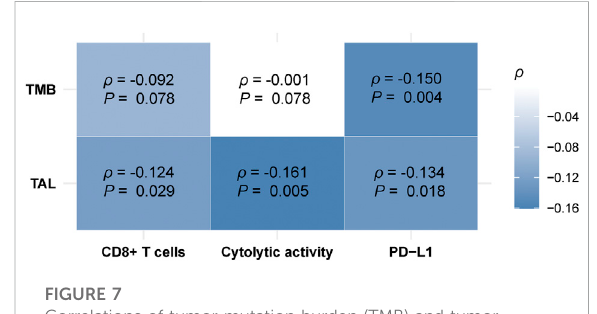
FIGURE 7 Correlations of tumor mutation burden (TMB) and tumor aneuploidy levels (TALs) with CD8 + T cell enrichment, cytolytic activity,and PD-L1 expressioninHCC.HeatmapshowingthatTALs have signi fi cant negative correlations with CD8 + T cell enrichment, cytolytic activity, and PD-L1 expression, and TALs have a signi fi cant negative correlation with PD-L1 expression in HCC. The Spearman correlation coef fi cients ( p ) and p -values are